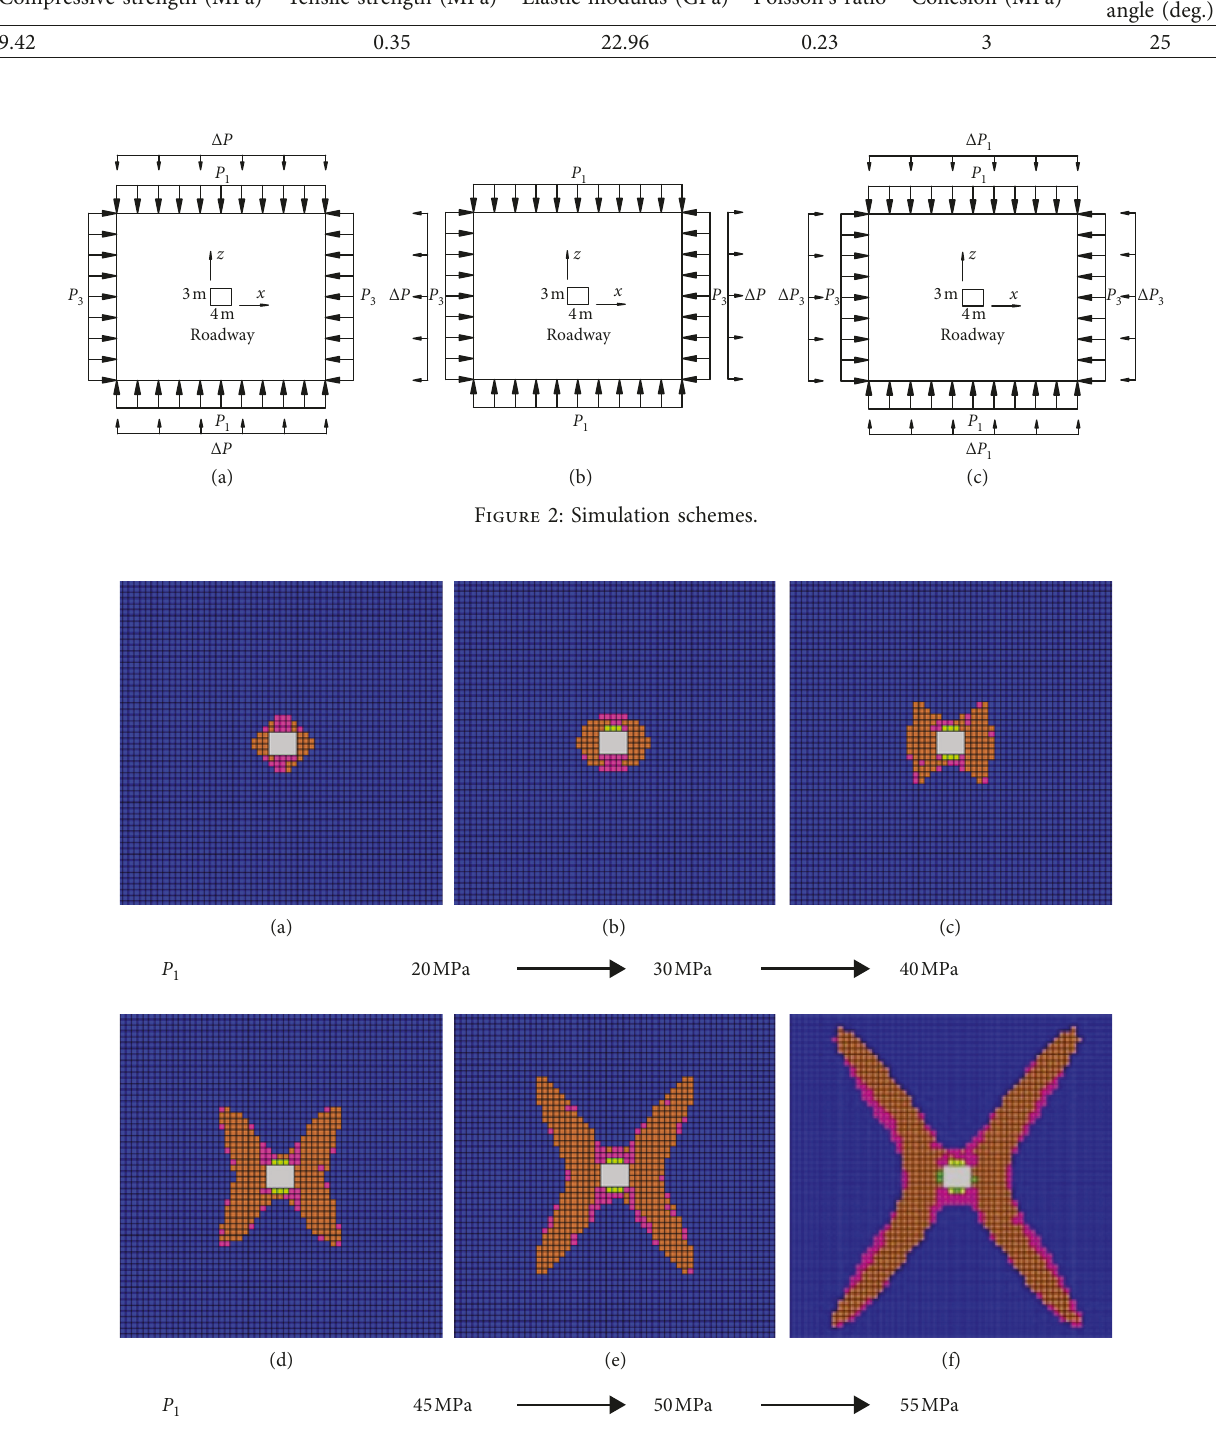
� 2.6m. (b) R � 3.6m. max max